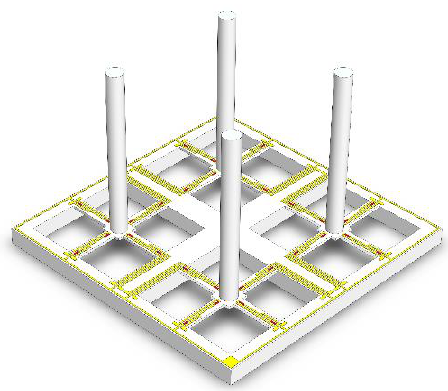
Figure 3. The FUVH structure. The piezoresistors are located at the root of the cross-beam and wired as a Wheatstone bridge.